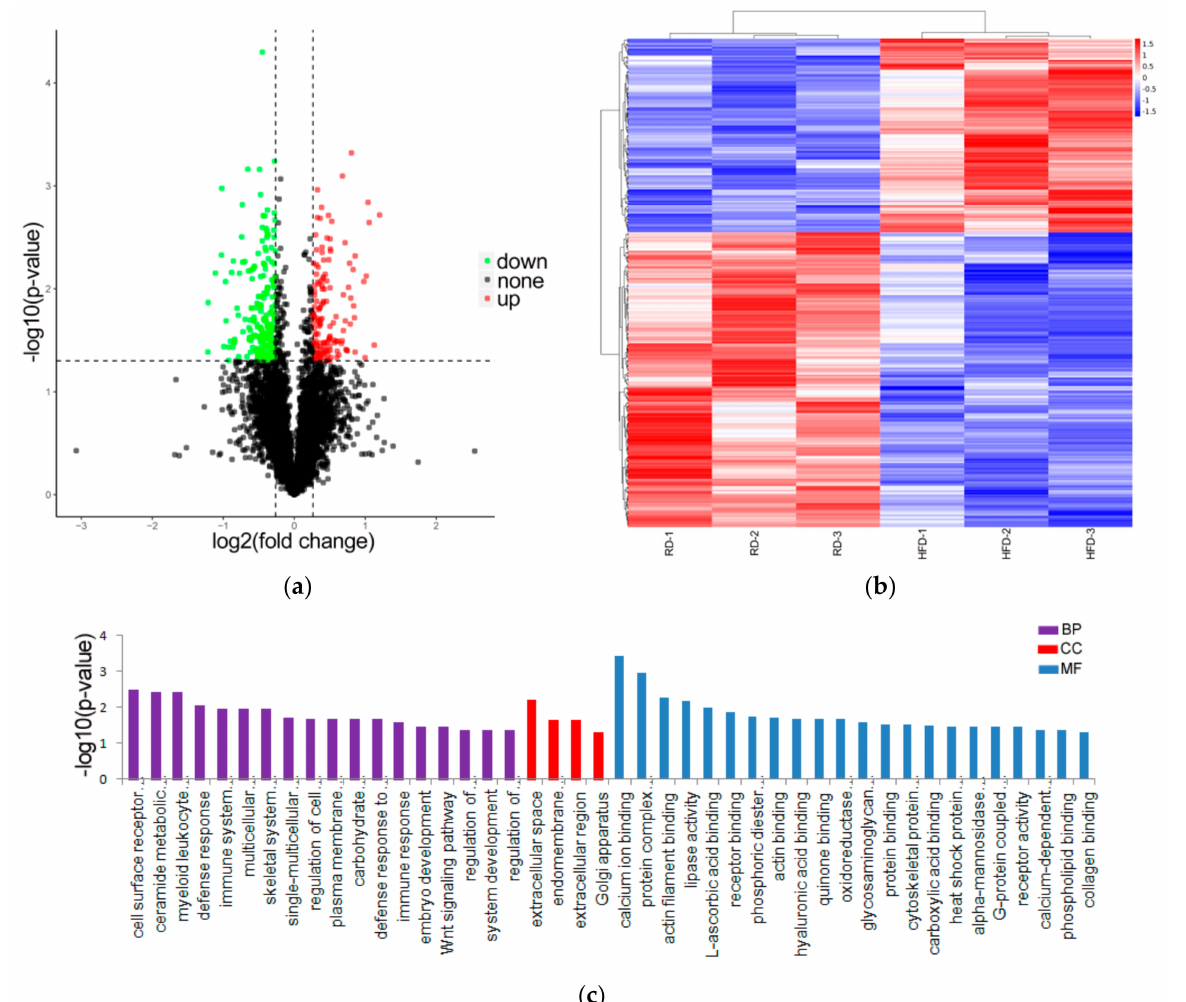
Figure 2. Identification and analysis of differentially expressed (DE) proteins. ( a ) Volcano map of DE proteins screened the HFD ( n = 3) and RD ( n = 3) groups and was built based on log2(fold change) and -log10( p -value). ( b ) Hierarchical clustering analysis of the DE proteins in the samples of HFD ( n = 3) and RD ( n = 3) (red represents upregulated proteins, and blue represents downregulated proteins). ( c ) The results from the DE proteins were applied to a GO analysis, only showing the significantly enriched GO terms ( p < 0.05). High-fat diet: HFD and restricted diet: